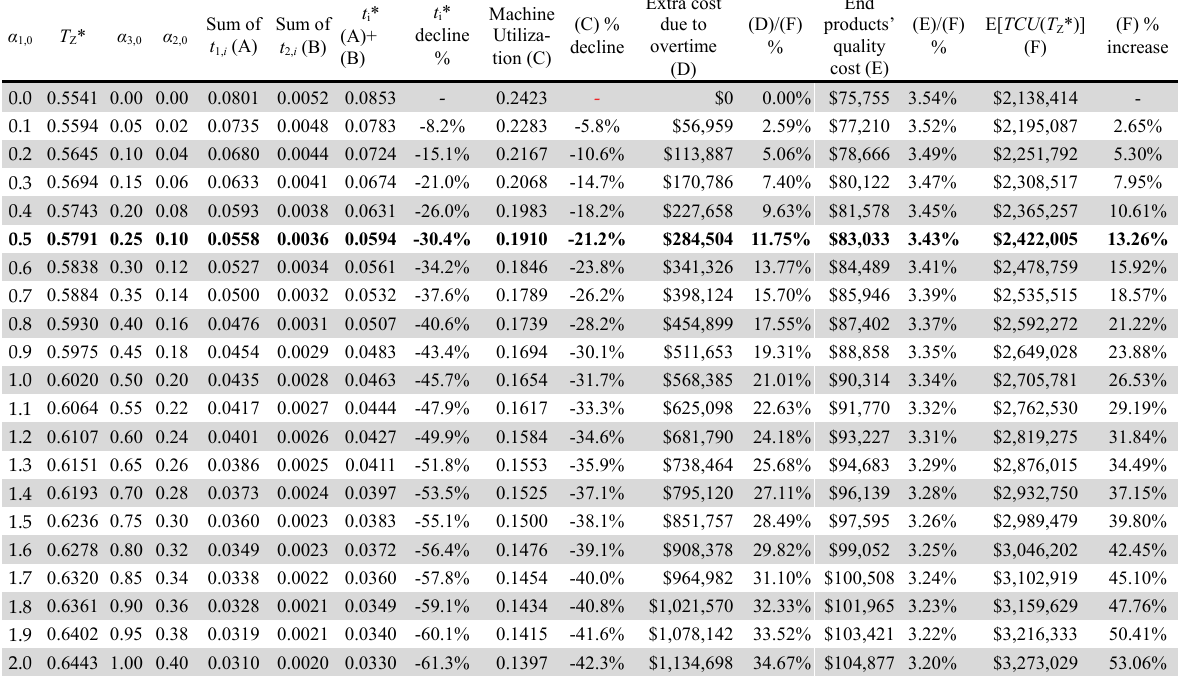
The impact of changes in overtime factor α 1,0 on various system